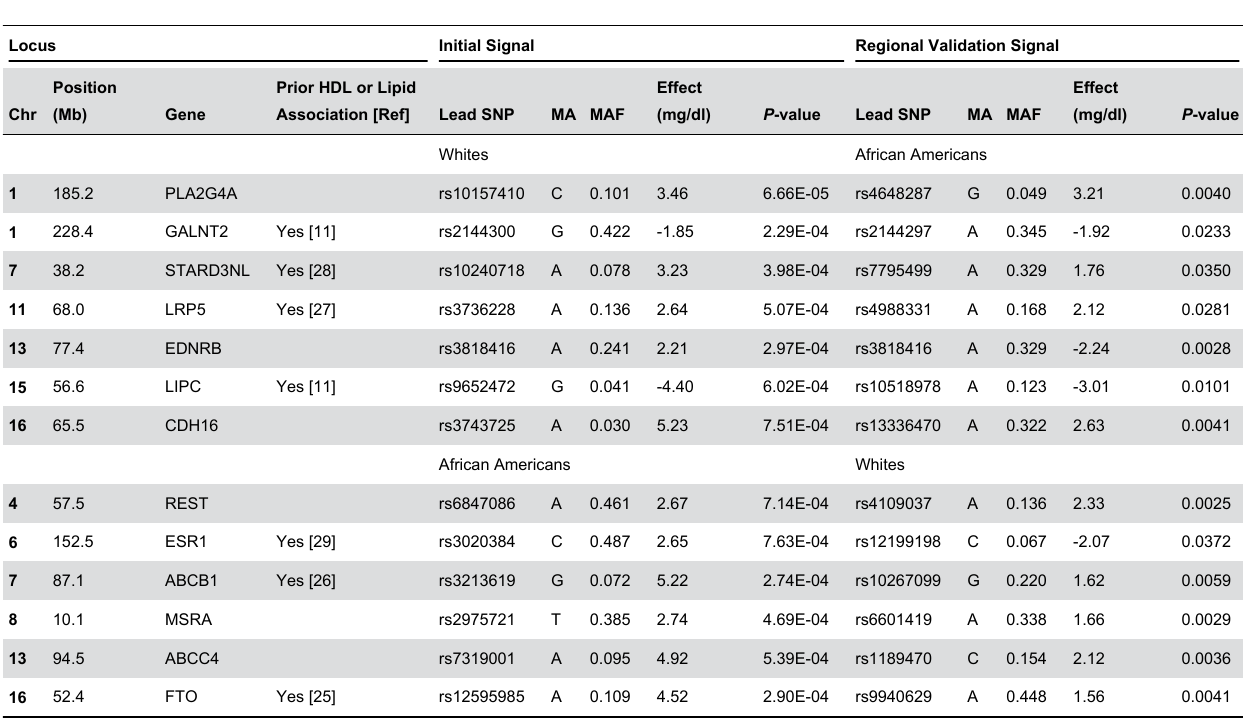
Table 2. Top gene regions associated with atenolol induced change in HDL-C a .